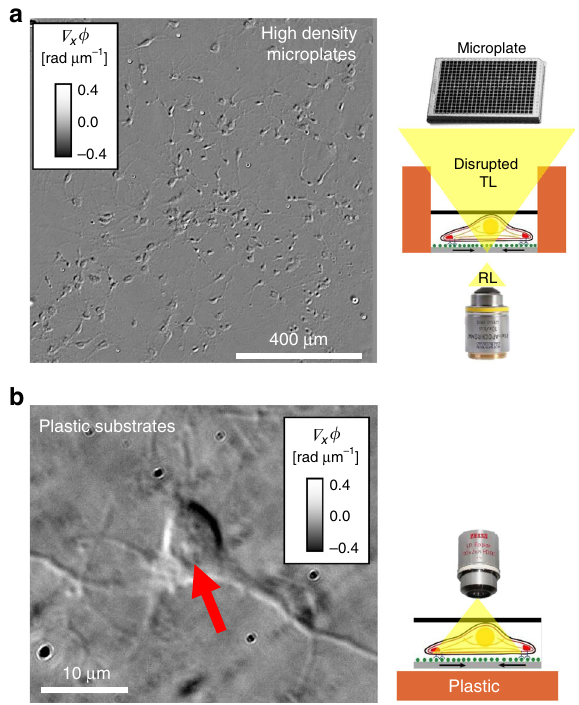
Fig. 3 Two challenging samples for transmission DIC a Re fl ected light imaging avoids the meniscus and high walls that make imaging microplates dif fi cult. Representative fi eld of view (×10/0.3) from a 1536 microplate. b Birefringent materials such as plastic substrates are incompatible with polarization-based contrast. This problem is overcome in epi-GLIM, by collecting the light before it passes through the birefringent material, revealing intracellular detail such as nucleoli (red arrow). Neurons were imaged after 7 days in vitro (×100/0.75